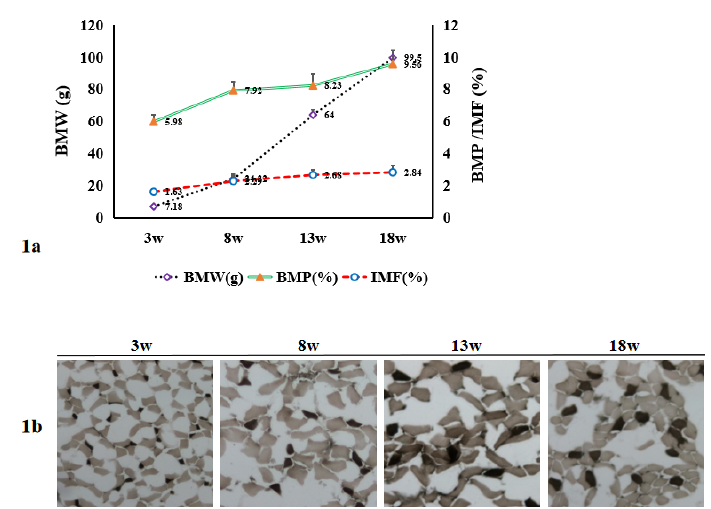
Figure 1. Breast muscle tissue characteristics in male chickens through development from 3 to 18 weeks. ( a ) Breast muscle weight (BMW), breast meat percentage (BMP, %), and intramuscular fat (IMF, %) continuously increased. n = 20. ( b ) Continuous hypertrophy of muscle fibers through development. Shown micrographs are at magnification of 40 × . n = 3.